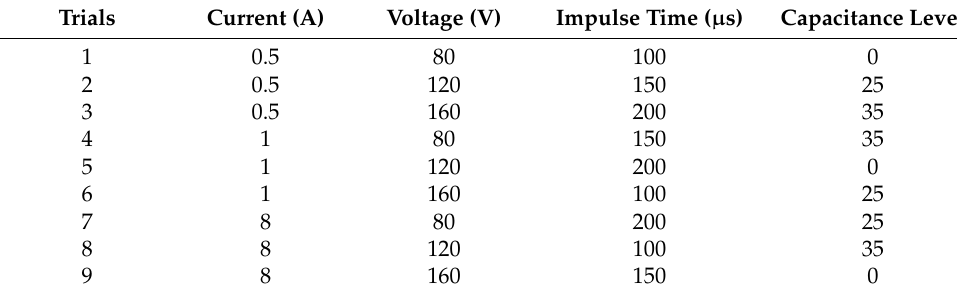
Table 5. Selected factors and experimental